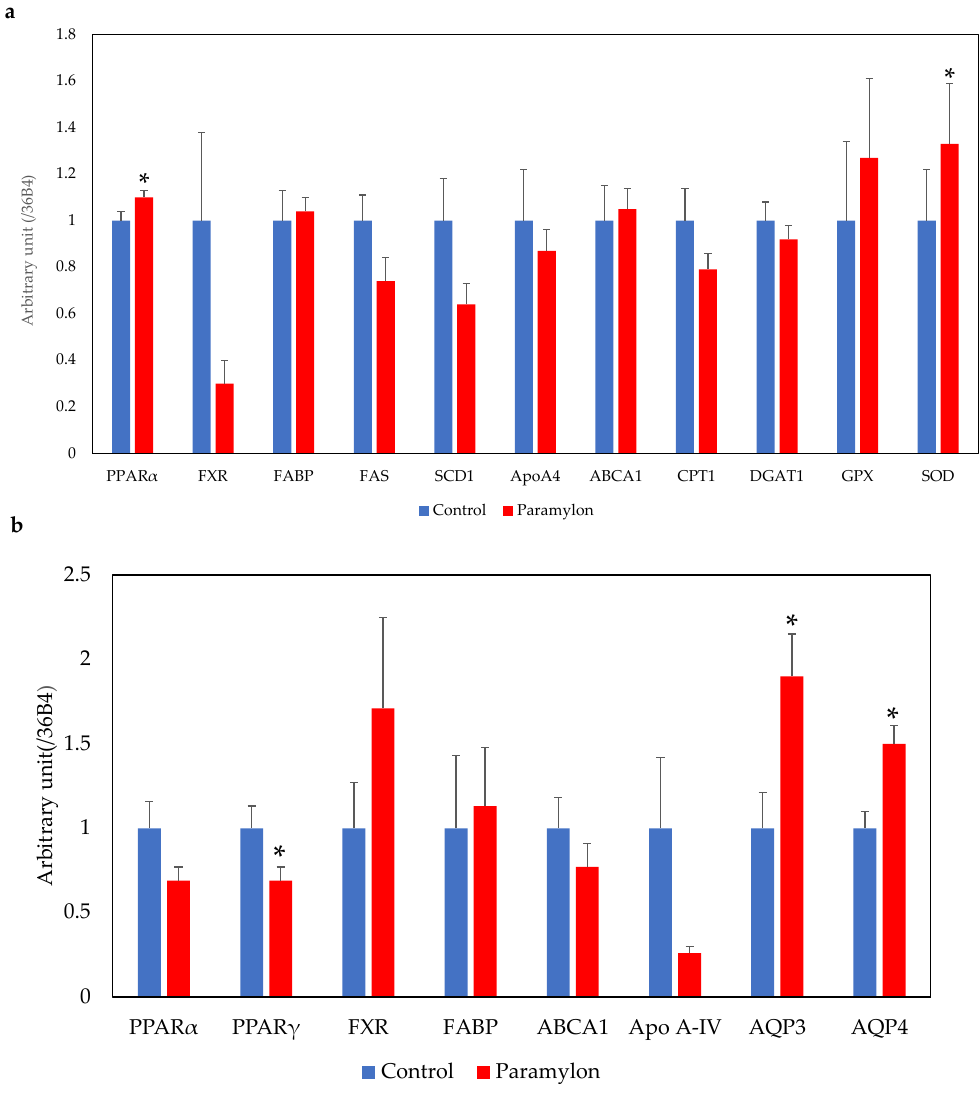
Figure 7. Relative expression levels of mRNAs involved in lipid metabolism in the liver ( a ) and ileum ( b ). Error bars represent standard error ( n = 10). * Significantly different from the control group ( p < 0.05). PPAR α , peroxisome proliferator-activated receptor α ; PPAR γ , peroxisome proliferator-activated receptor γ ; FXR, farnesoid X receptor; SCD1, stearoyl-CoA desaturase 1; Apo A-IV, apolipoprotein A-IV; ABCA1, ATP-binding cassette transporter A1; CPT1, carnitine palmitoyltrans- ferase 1; DGAT1, diacylglycerol O-acyltransferase 1; GPX, glutathione peroxidase; SOD, superoxide dismutase; AQP 3,4, aquaporin 3,4.